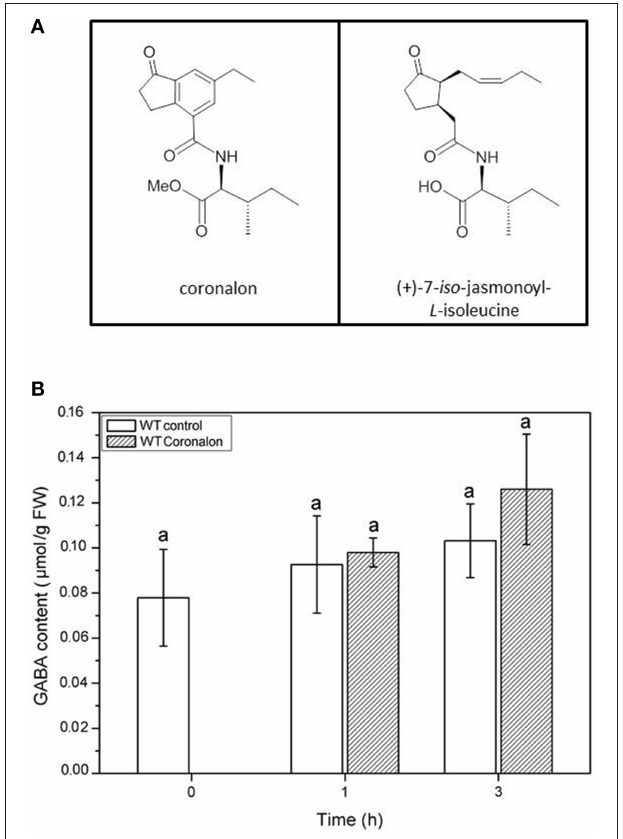
FIGURE 8 | Accumulation of GABA after coronalon treatment in wild-type (WT) plants. (A) Structures of ( + )-7- iso -jasmonoyl-L-isoleucine (JA-Ile) and structural mimic 6-ethyl indanoyl isoleucine (coronalon). (B) Mean ( ± SE, n = 10 ) levels of GABA were determined after spray with solvent control (0.1% ethanol, white) or 50 µ M coronalon 1 and 2h after treatment. Statistically significant differences between the treatments were analyzed by One-way ANOVA ( p < 0.05 , SNK-test) and are indicated by different